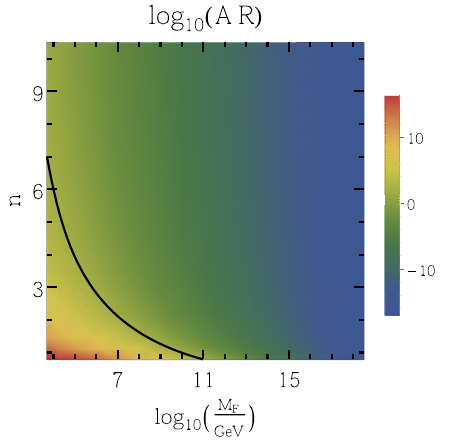
(cid:2) (cid:3) A l R Fig. 1 log 10 in dependence of the number of extra dimensions n and the new fundamental scale of gravity M F with h l line corresponds to the values, where A l R = 1 is obtained. Above this line a seesaw like scenario will take place, whereas below this line A l R (cid:8) 1 could hold and thus generate a scenario similar to pseudo Dirac